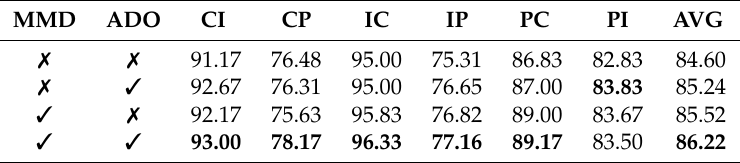
Table 4. Ablation study. Classification accuracy (%) with different measures.